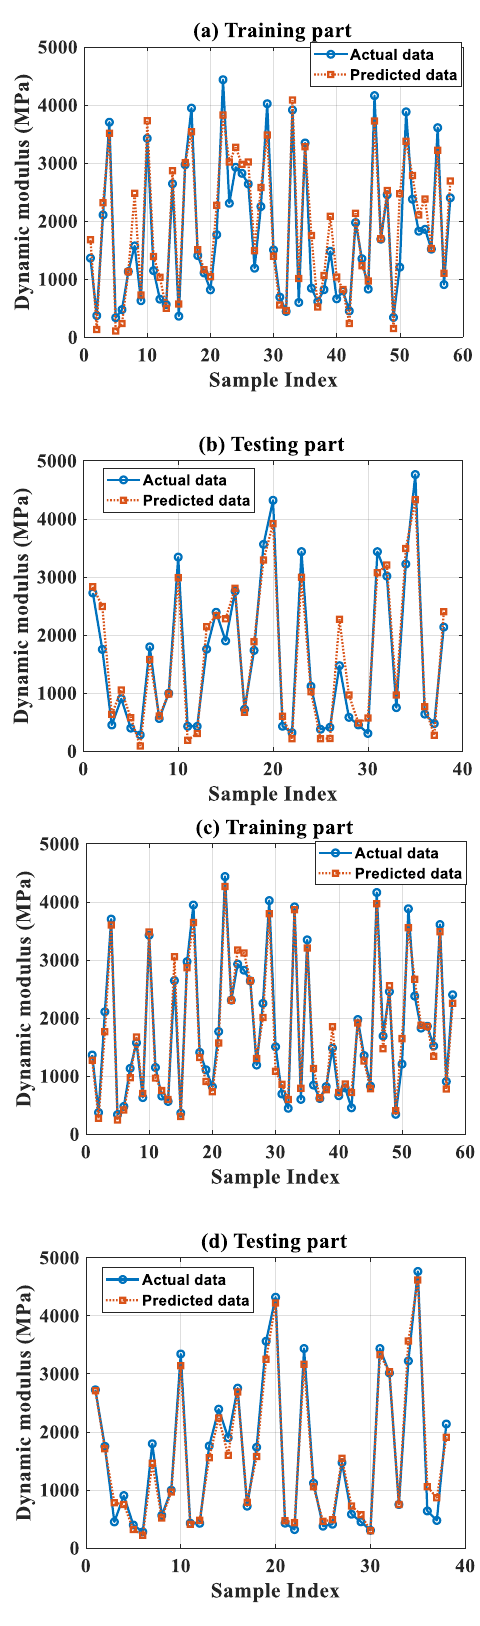
Figure 8. Dynamic modulus in function of sample index, using individual ANN model for ( a ) training part and ( b ) testing part, using ANN-TLBO model for ( c ) training part and ( d ) testing part.